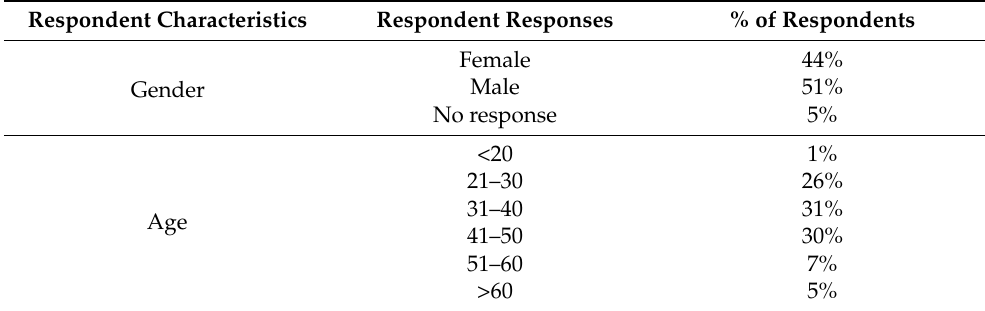
Table 1. Survey demographic